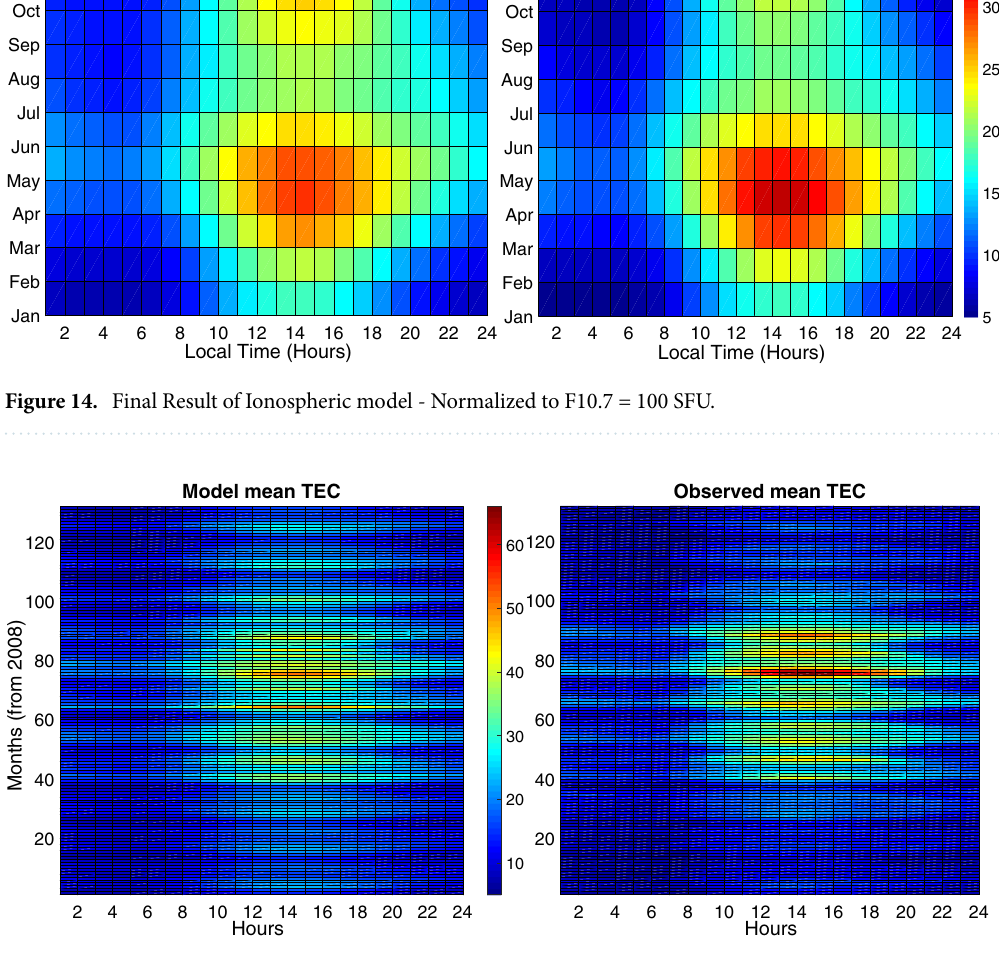
Figure 15. Final Result of Ionospheric model for the entire cycle. Left panel represents the result of our semi- empirical model, whilst right panel represents mean values of observed TECs. The model response is best for higher solar